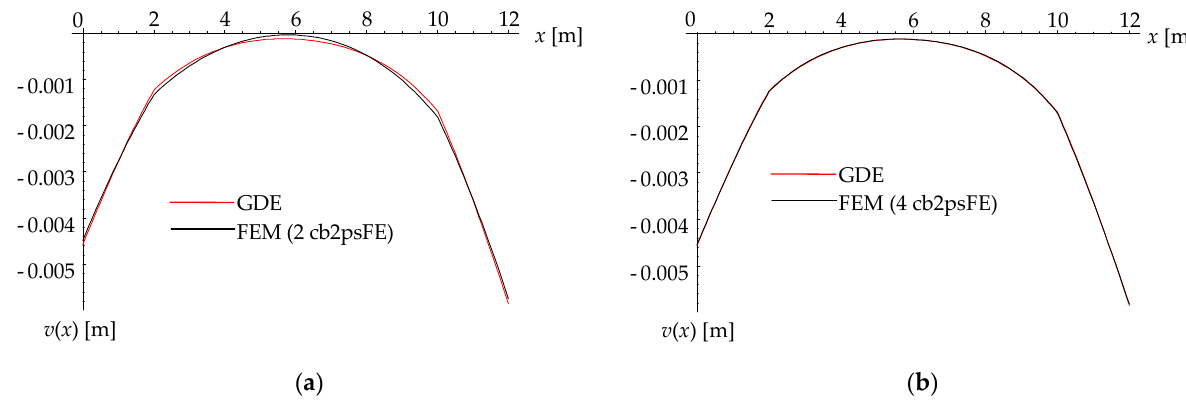
Figure 3. Comparison of transverse displacements for two ( a ) and four ( b ) FE meshes, respectively.